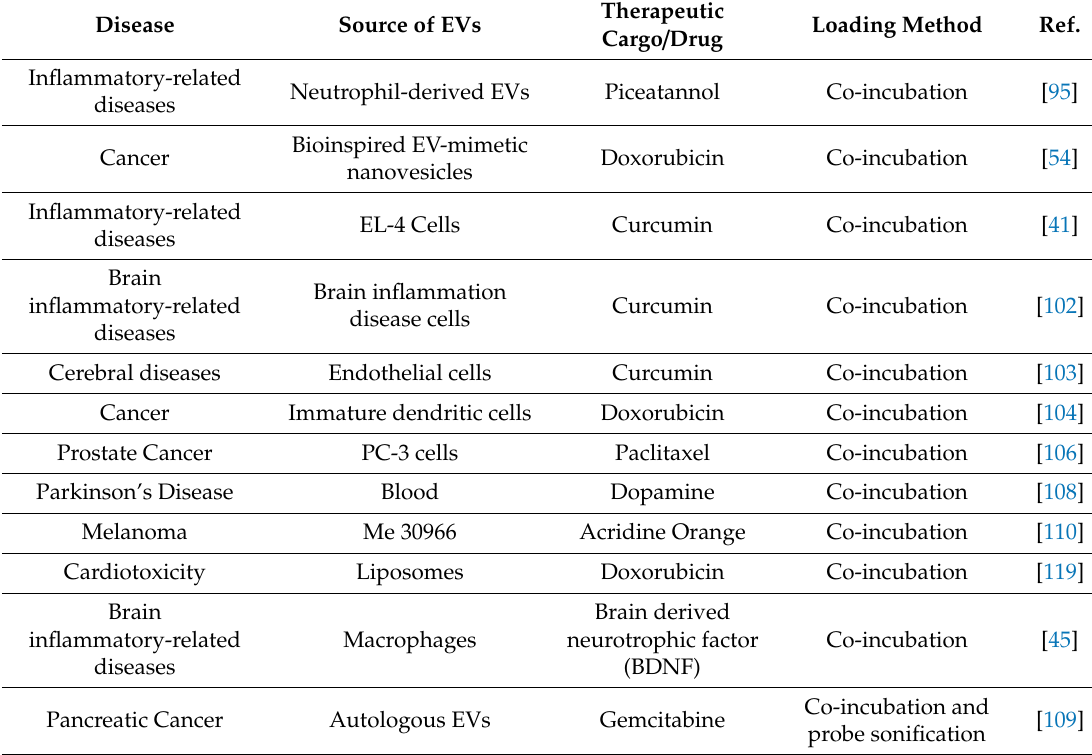
Table 1. Summary of preclinical investigations with EV-based drug formulations obtained via exogenous